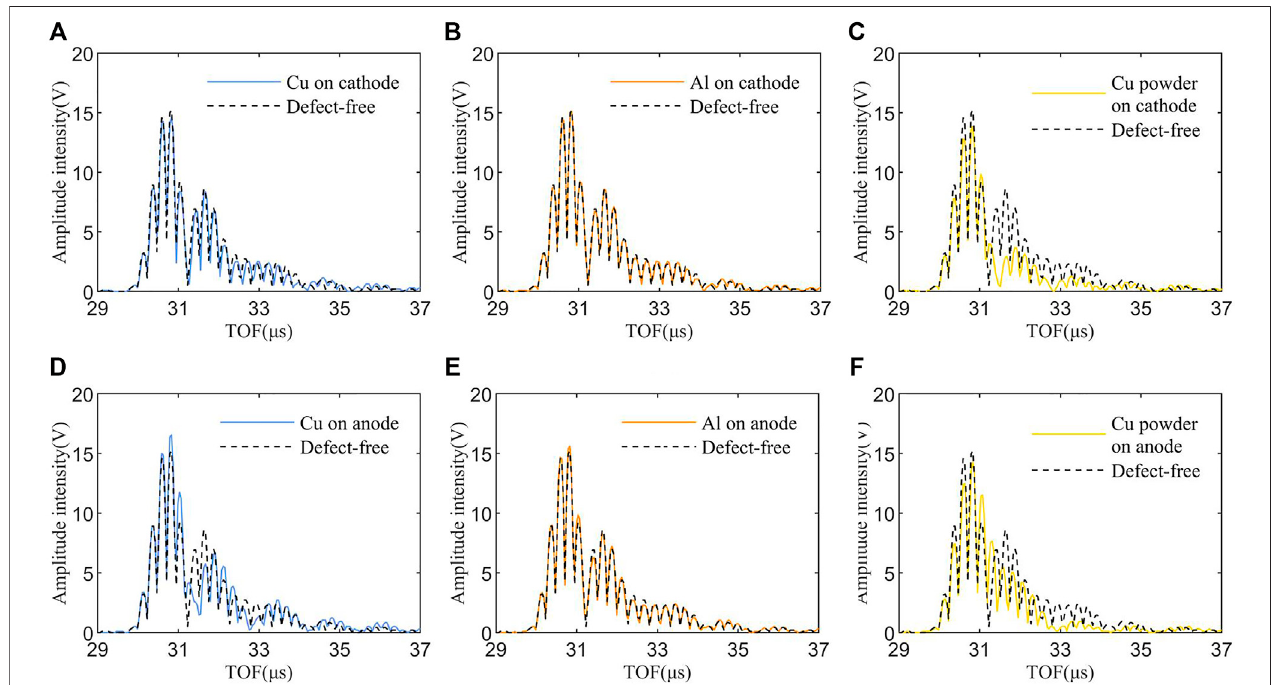
FIGURE 10 | Transmission signal of Cu foil, Al foil and copper powder on cathode and anode surface vs. transmission signal of defect-free position.